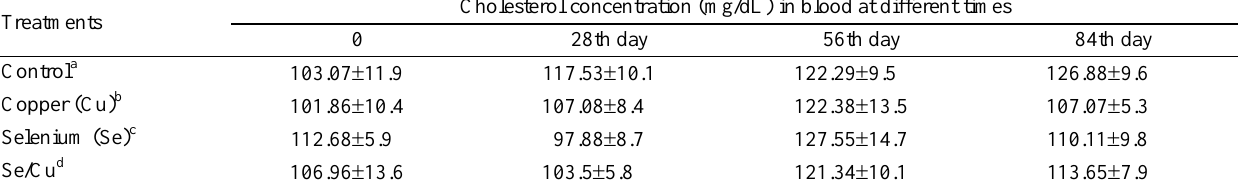
Table 4. Concentration of cholesterol and standard deviations in mg/dL, in cattle blood on the 0, 28th, 56th, 84th day receiving control diet (without supplementation of selenium and copper), copper (40 mg/kg of DM), selenium (2 mg/kg of DM), or selenium (2 mg/kg of DM)/copper (40 mg/kg of DM) Treatments